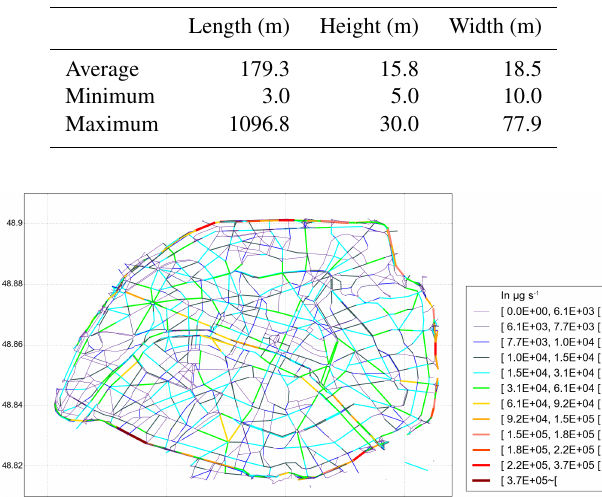
Figure 5. Average traffic emissions of NO 2 (µgs − 1 ) calculated for local-scale simulations.